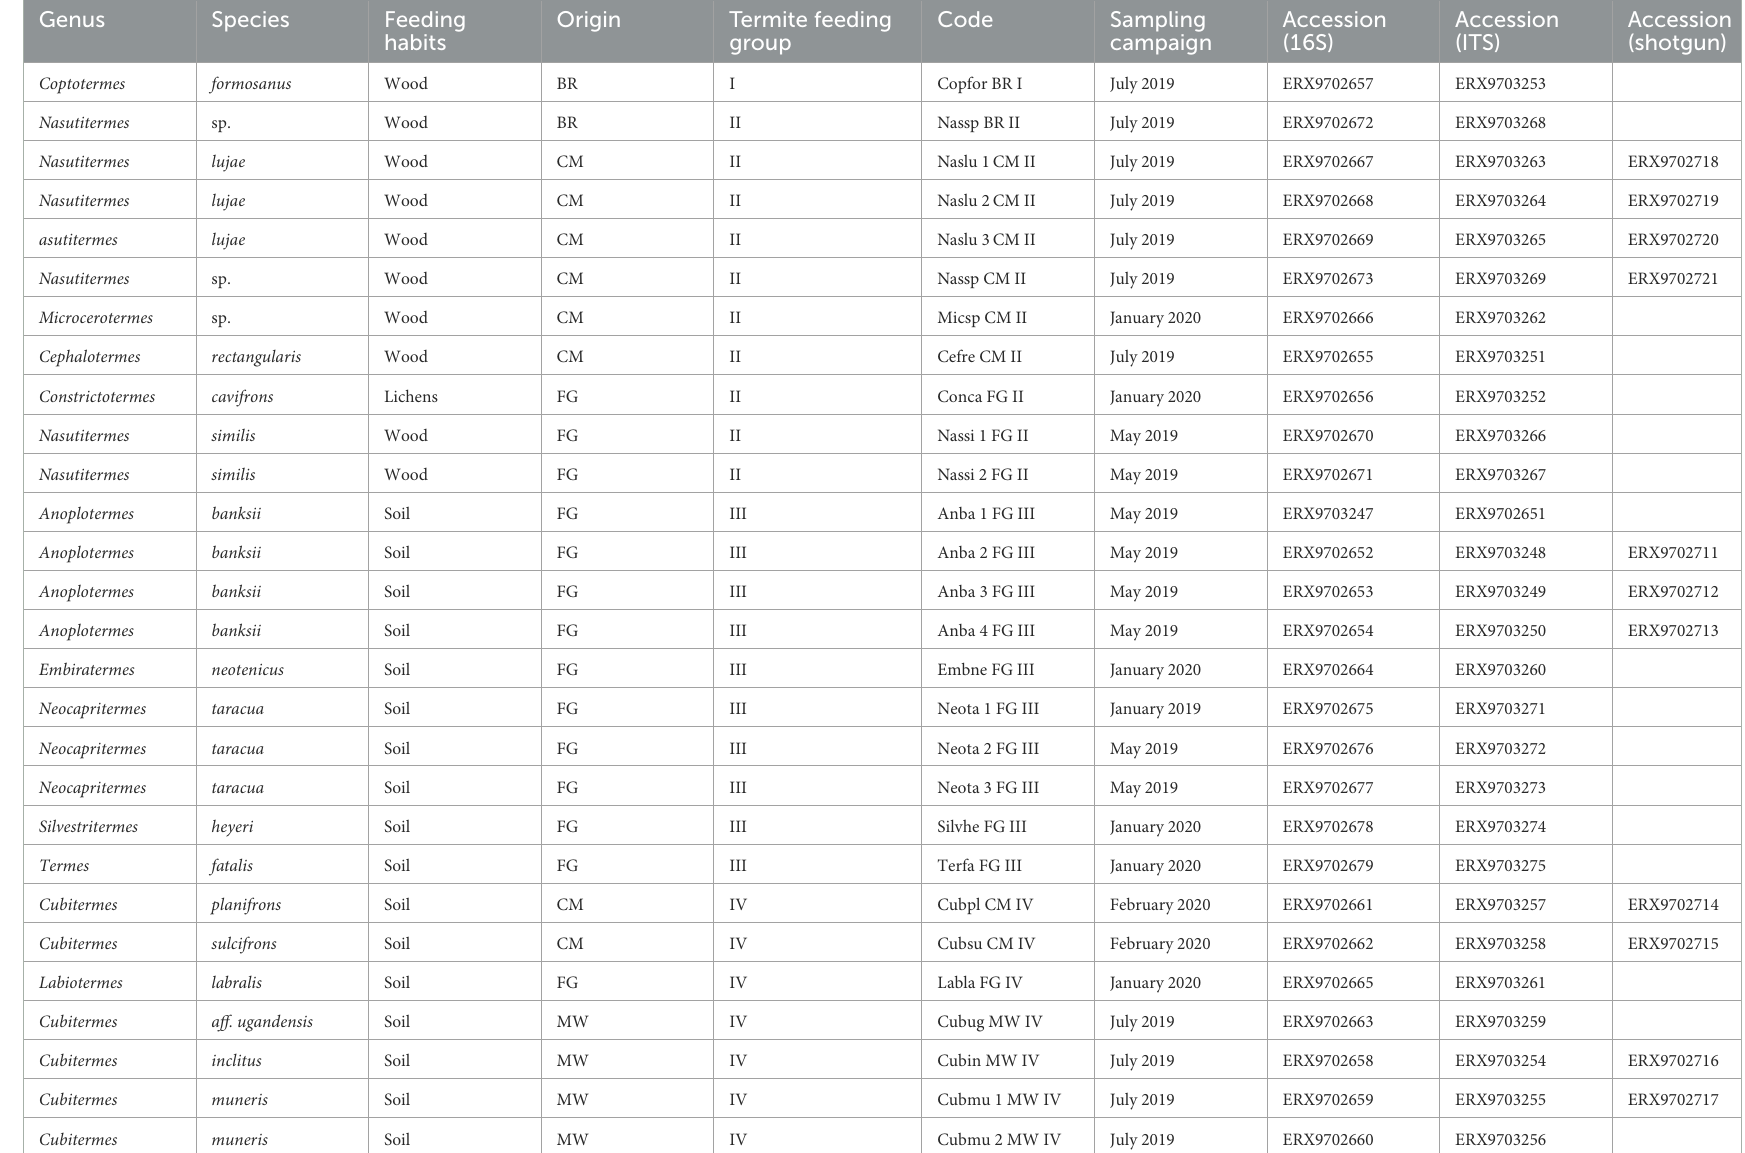
TABLE 1 Species identification after COII